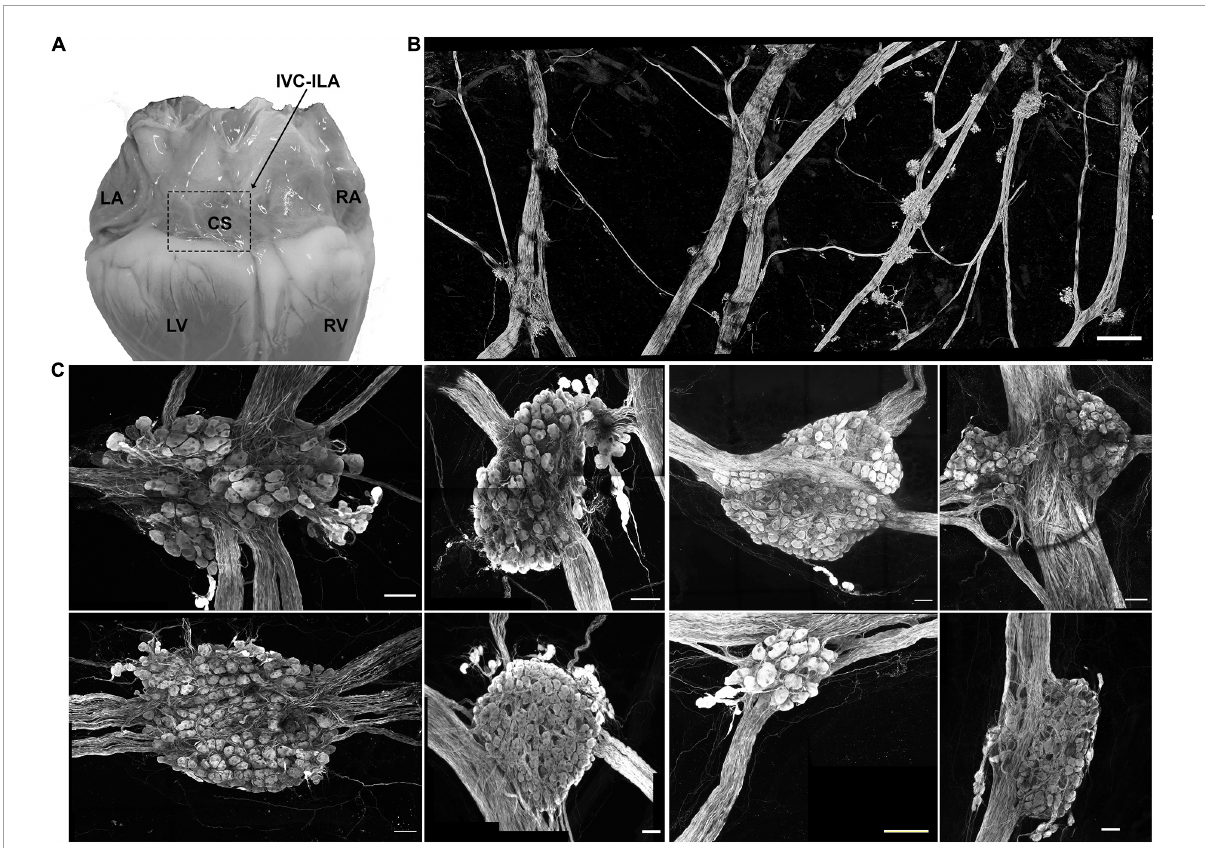
FIGURE2 Neuroanatomy of the IVC-ILA ganglionated plexus. (A) Area of the IVC-ILA is circumscribed by the hatched line on a photograph of the dorsal surface of the porcine heart. LA, left atrium; RA, right atrium; CS, coronary sinus; LV, left ventricle; RV, right ventricle. (B) Stitched confocal image (10 × ) showing the network of interganglionic nerves and intrinsic cardiac ganglia within the boxed area in (A) . scale bar: 1 mm (C) Representative examples of intrinsic cardiac ganglia isolated from control ( left four panels ) and MI ( right four panels ) pig hearts. Scale bars: 100 µ